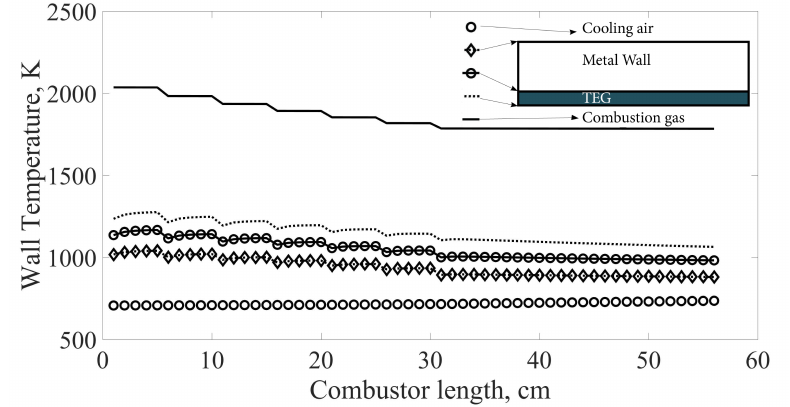
Figure 8. Temperature variation at various points across the combustion chamber wall with TEGs made of Si . Fill factor: 21%, L TEG :0.0011 m, I: 23.5A.